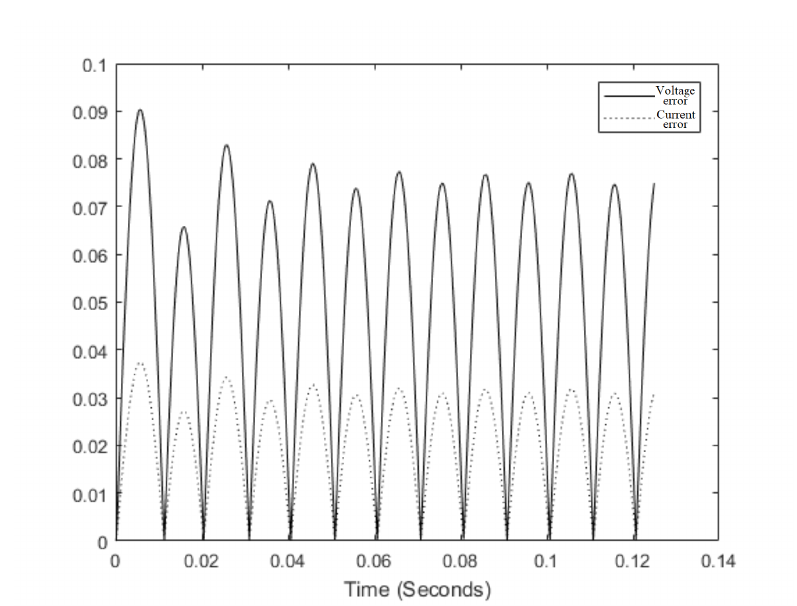
Figure 21. Simulink-NIS method error results.